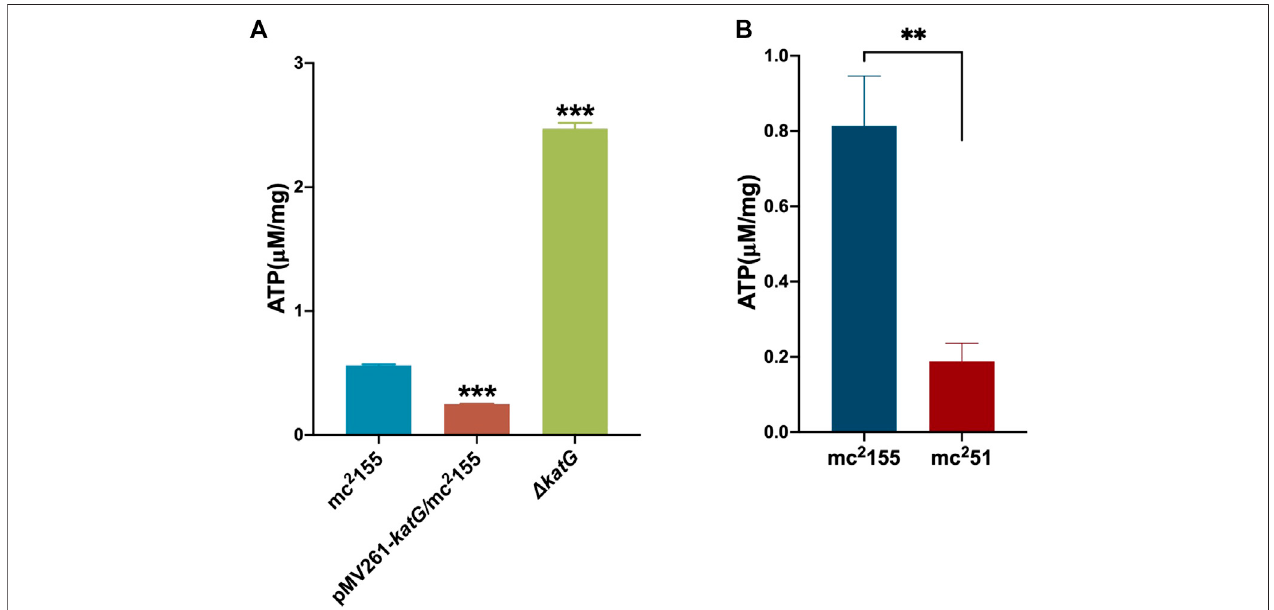
FIGURE3| ATPcontentinmc 2 51issimilartothatinpMV261- katG /mc 2 155. (A) ThedetectionofATPcontentinmc 2 155, Δ katG ,andpMV261- katG /mc 2 155.The cultures of mc 2 155 (navy blue), pMV261- katG /mc 2 155 (brown), and Δ katG (olive drab) at an OD 600 of 0.8 were collected. ATP levels were measured in relative light unit (RLU) using a Cytation 3 Cell Imaging Multi-Mode Reader. The corresponding ATP concentrations were calculated according to the ATP standard curve and further convertedto μ M/mgprotein.Dataarepresentedasthemean±standarddeviationofthreeindependentreplicates.*** p < 0.001. (B) TheintracellularATPcontentof mc 2 51andmc 2 155.Theculturesofmc 2 155(navyblue)ormc 2 51(brown)atanOD 600 of0.8werecollected.ATPlevelsweremeasured inrelativelightunit(RLU)usinga Cytation 3 Cell Imaging Multi-Mode Reader. The corresponding ATP concentrations were calculated according to the ATP standard curve and further converted to μ M/ mg protein. Data are presented as the mean ± standard deviation of three independent replicates. ** p < 0.01.